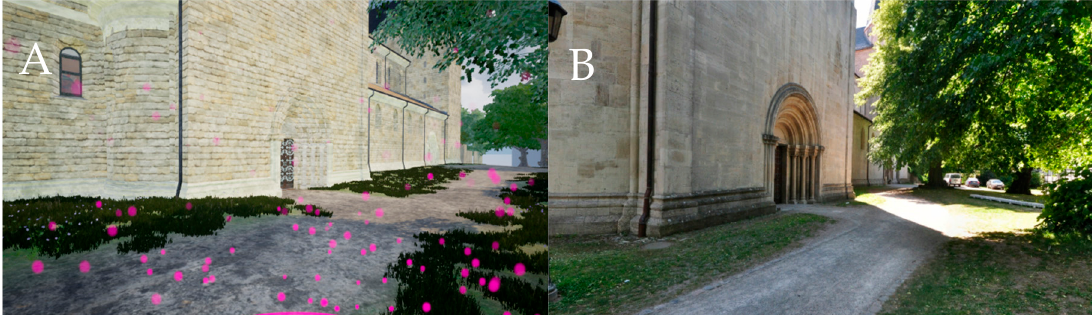
Figure 9. View from the same position in the virtual world, with the panorama switched off ( A ) and on ( B ).